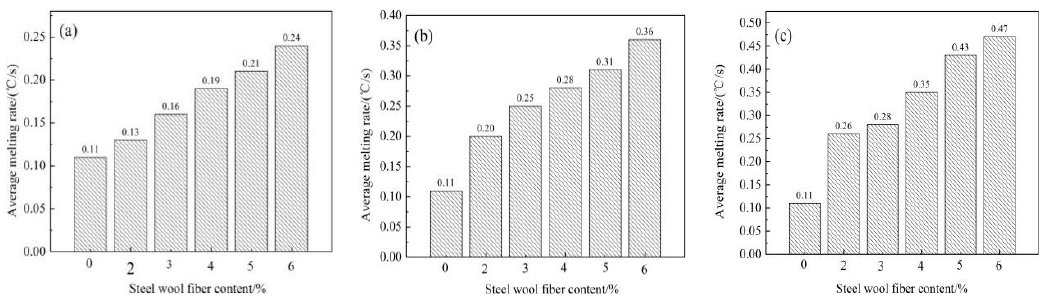
( c ) Figure 13. The variation laws of content and length of steel wool fiber and average deicing rate. ( a ) 1 mm; ( b ) 3 mm;